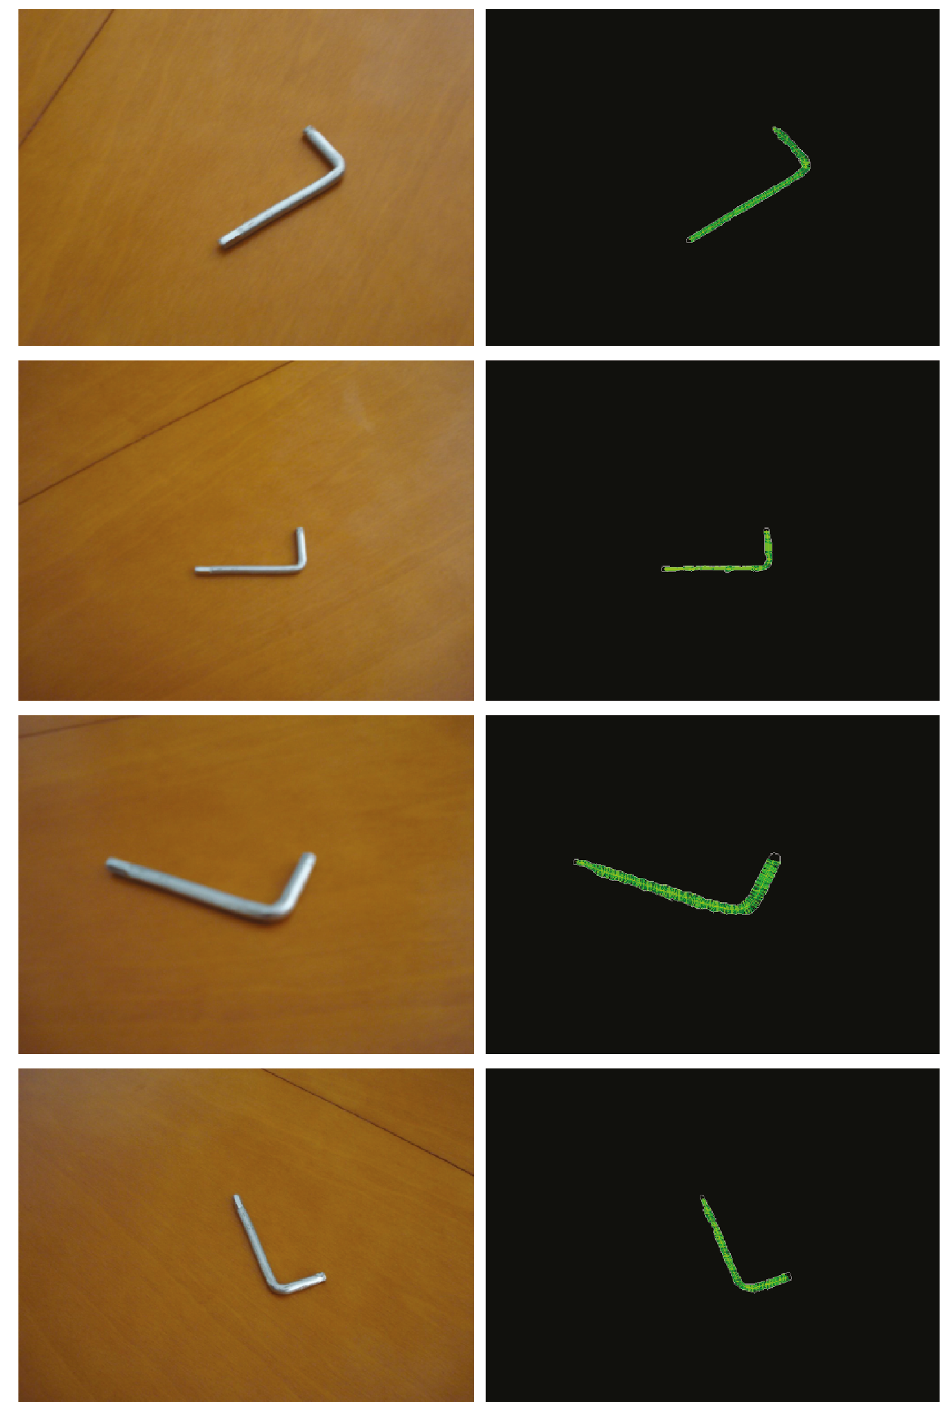
Figure 8: Detection test of the same object under di ff erent viewing conditions. In the first column, the original images are depicted. In the second column, the curvilinear regions are drawn. The object has been always detected as a curvilinear